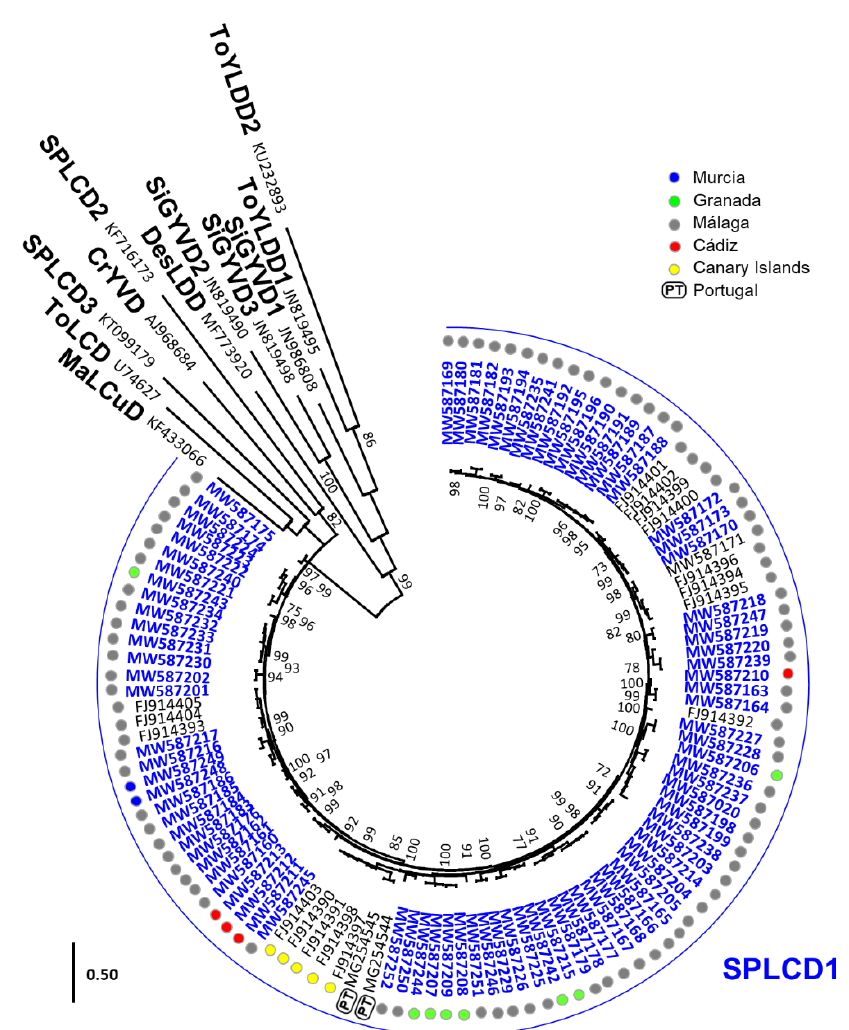
Figure 3. Phylogenetic tree illustrating the relationship of isolates of the deltasatellites obtained in this work (highlighted in blue) with sweet potato leaf curl deltasatellite 1 (SPLCD1) isolates previously reported from Spain and Portugal and one representative isolate of all other deltasatellite species. Samples were obtained from Murcia (blue dots), Granada (green dots), Málaga (gray dots), and Cádiz (red dots) provinces in southern continental Spain and the Canary Islands (yellow dots). The tree was constructed by the maximum likelihood method with the MEGA 7 program using the best fit model T92 + G [31], and bootstrap values (500 replicates) are shown for supported branches (>70%). The bar below the tree indicates 0.50 nucleotide substitutions per site. Additional details on the sequences and deltasatellite names are included in Tables S1 and S3.